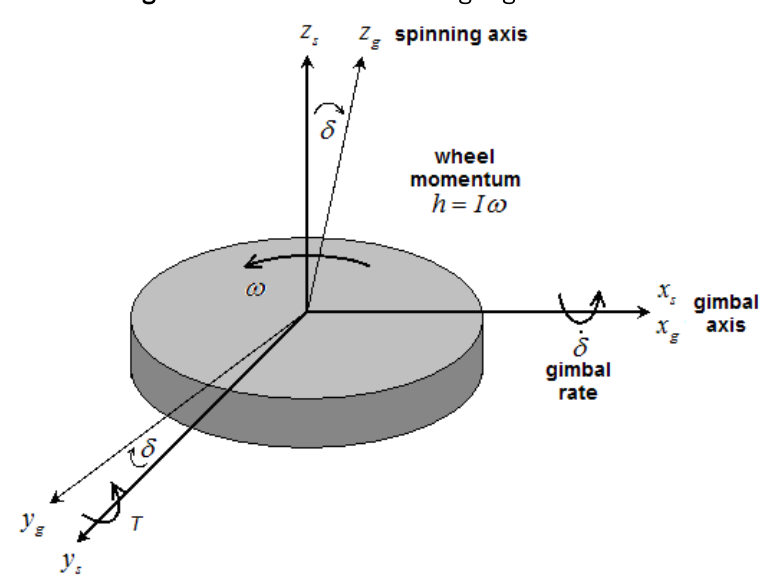
Figure 1. Schematic of a single gimbal